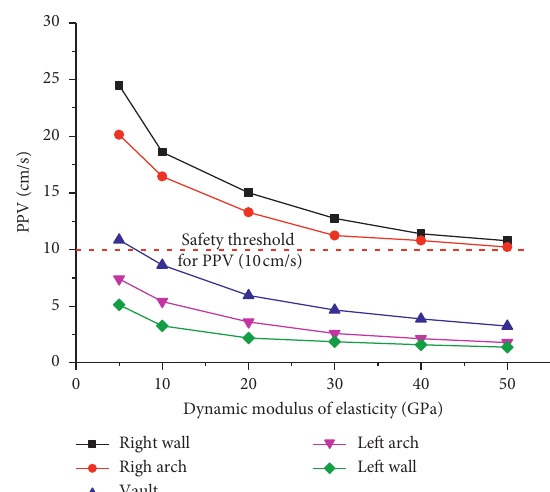
Figure 10: Changes of maximum PPV with a dynamic modulus of